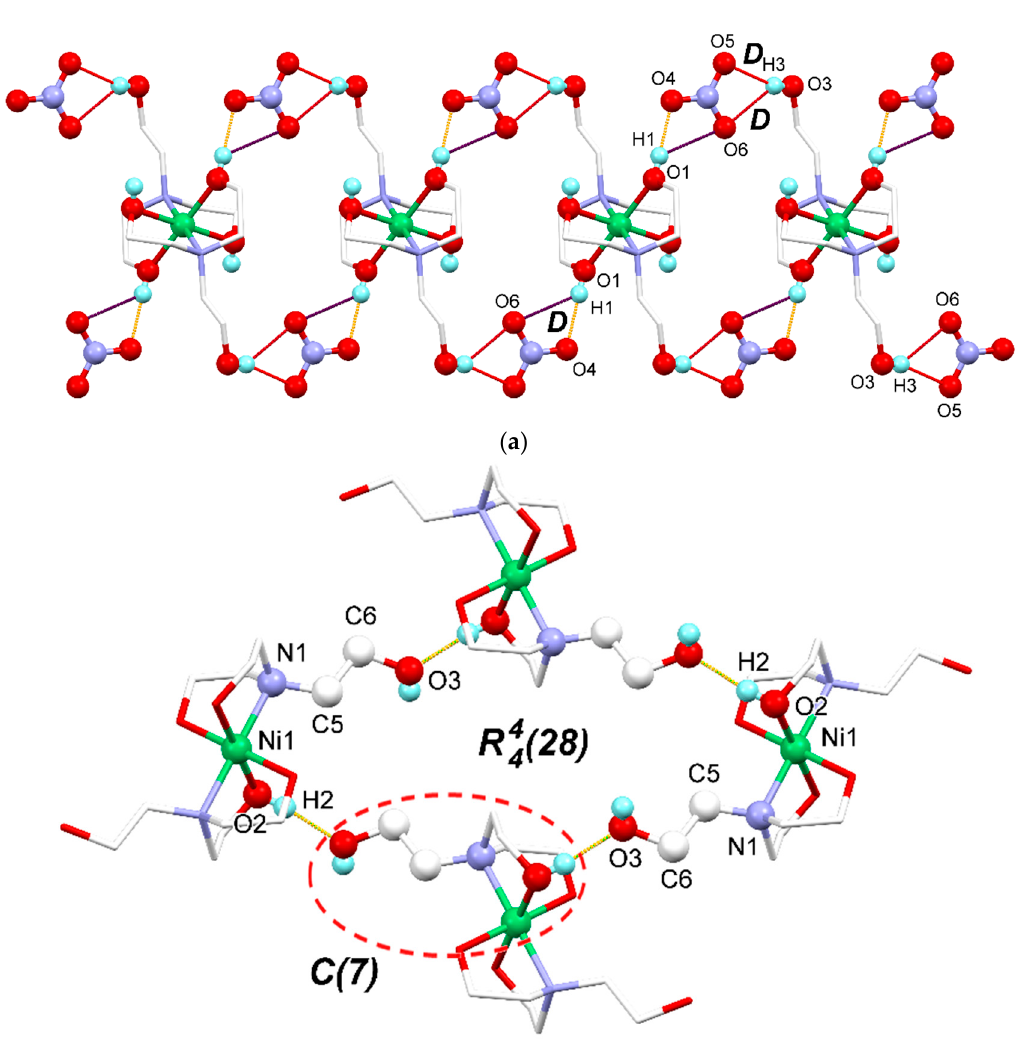
Figure 2. Crystal packing of the Ni-TEA complex showing ( a ) discrete hydrogen bonds ( D ), O1–H1 ··· O4, O3–H3 ··· O5, and O3–H3 ··· O6, viewing along the [001] axis, ( b ) O2–H2 ··· O3 hydrogen bonding chain with the C(7) graph set and the hydrogen bonding ring with the R 4 (28) graph set, viewing along the [100] axis. The different colors show the hydrogen bonds with different distances where yellow, red and blue represent short, middle and long interactions, respectively.